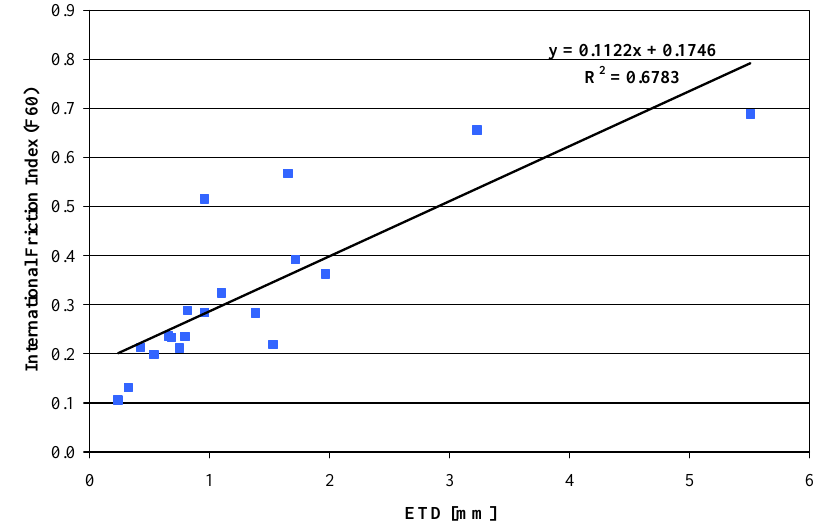
Fig. 7. CT meter ETD versus